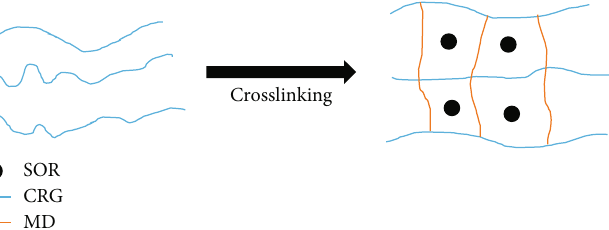
Figure 2: Schematic reaction mechanism process of CRG (carrageenan), MD (maltodextrin), and SOR (sorbitol).